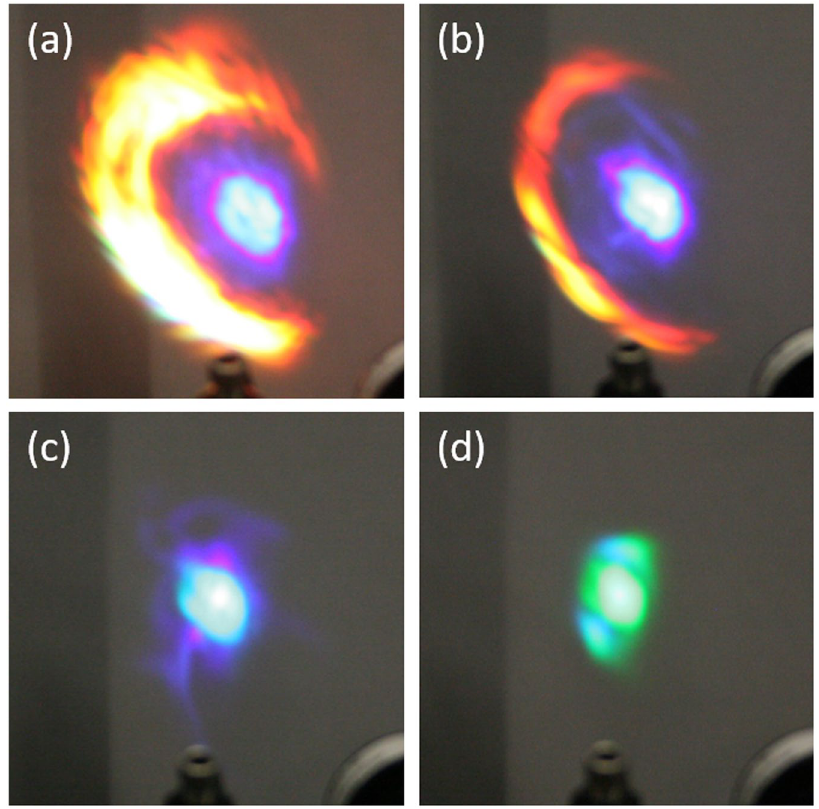
Figure 2. Supercontinuum generation imaged onto a sheet of blank white paper. Source wavelength for each continuum is ( a ) 1300 nm ( b ) 1400 nm ( c ) 1500 nm ( d ) 1600 nm.